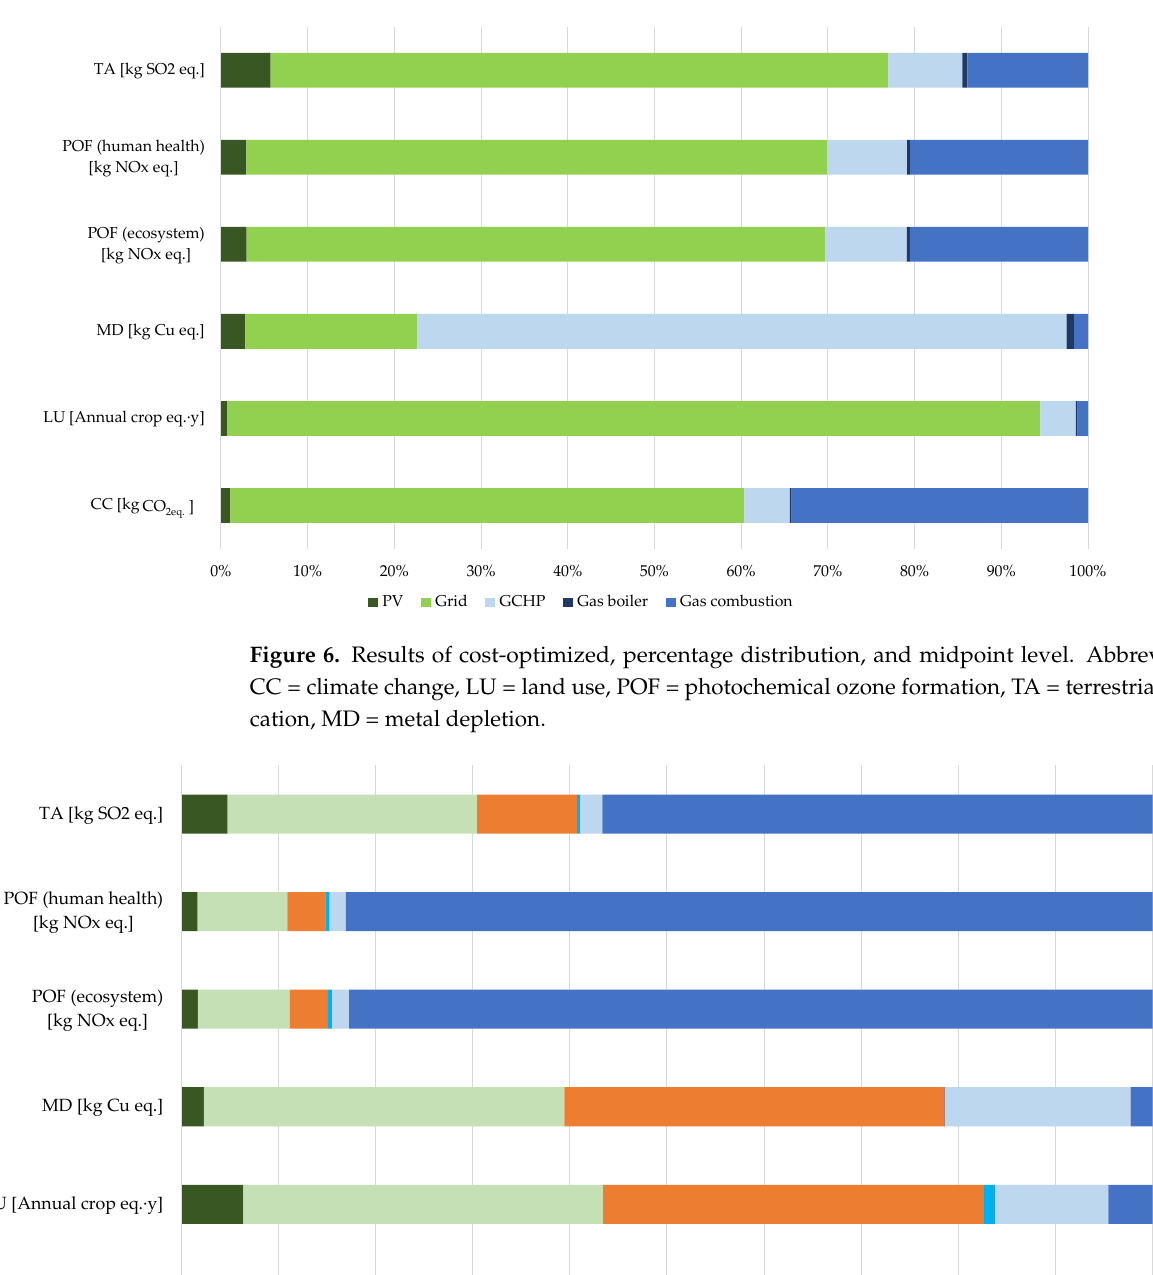
Figure 5. Results of base case, percentage distribution, midpoint level. Abbreviations: CC = climate change, LU = land use, POF = photochemical ozone formation, TA = terrestrial acidification, MD = metal depletion.